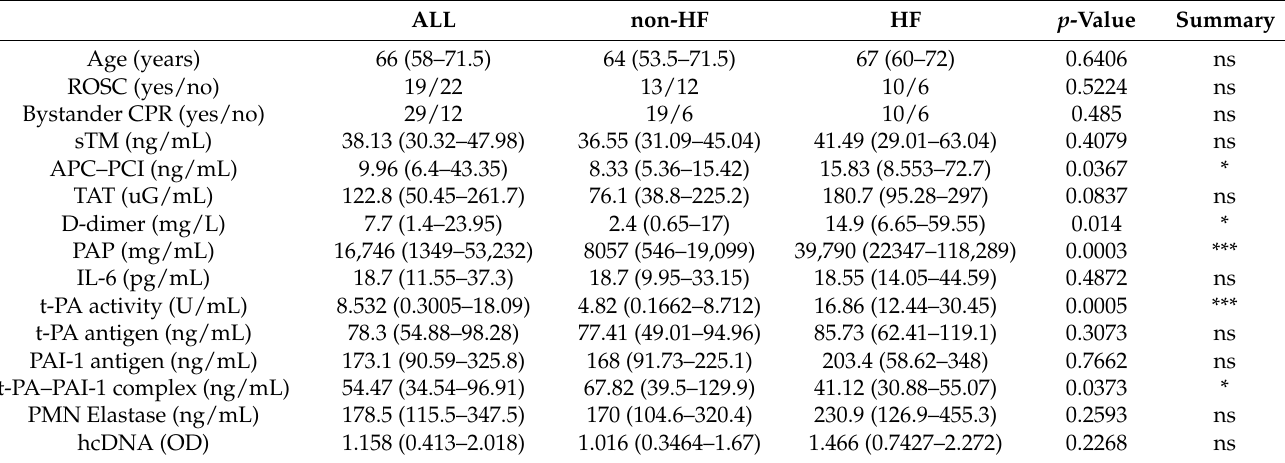
Table 1. Patient characteristics and assessed parameters in plasma.